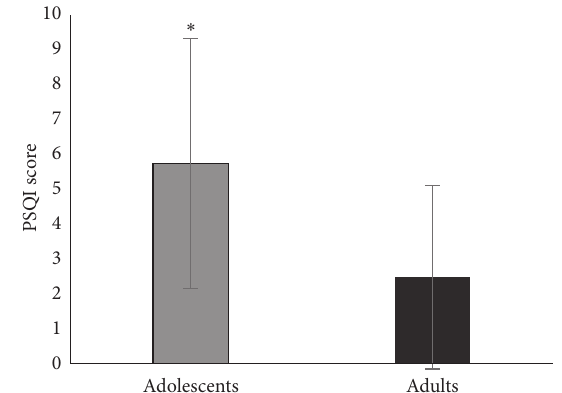
Figure 2: Relationship between adolescents and adults soccer players in PSQI score. ∗ P < 0 .